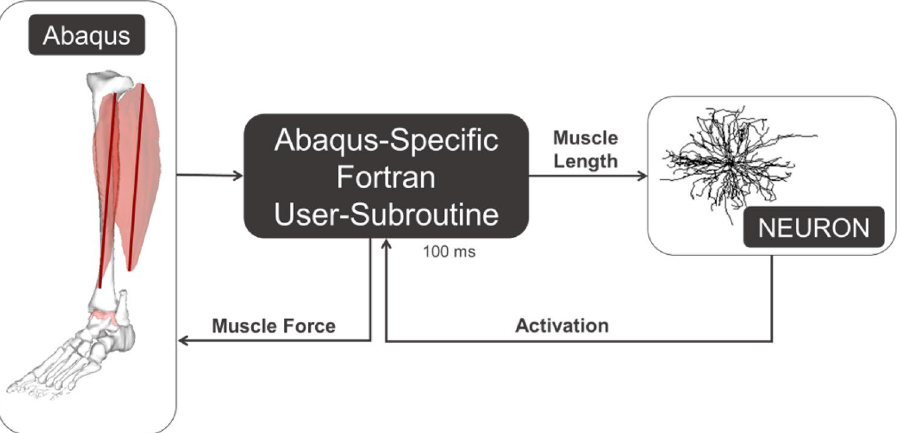
Figure 8. Flow of information in the integrated FE NMS model. A NEURON simulation is performed using a call from the Abaqus-specific Fortran user-subroutine every 100 ms. From that simulation, the